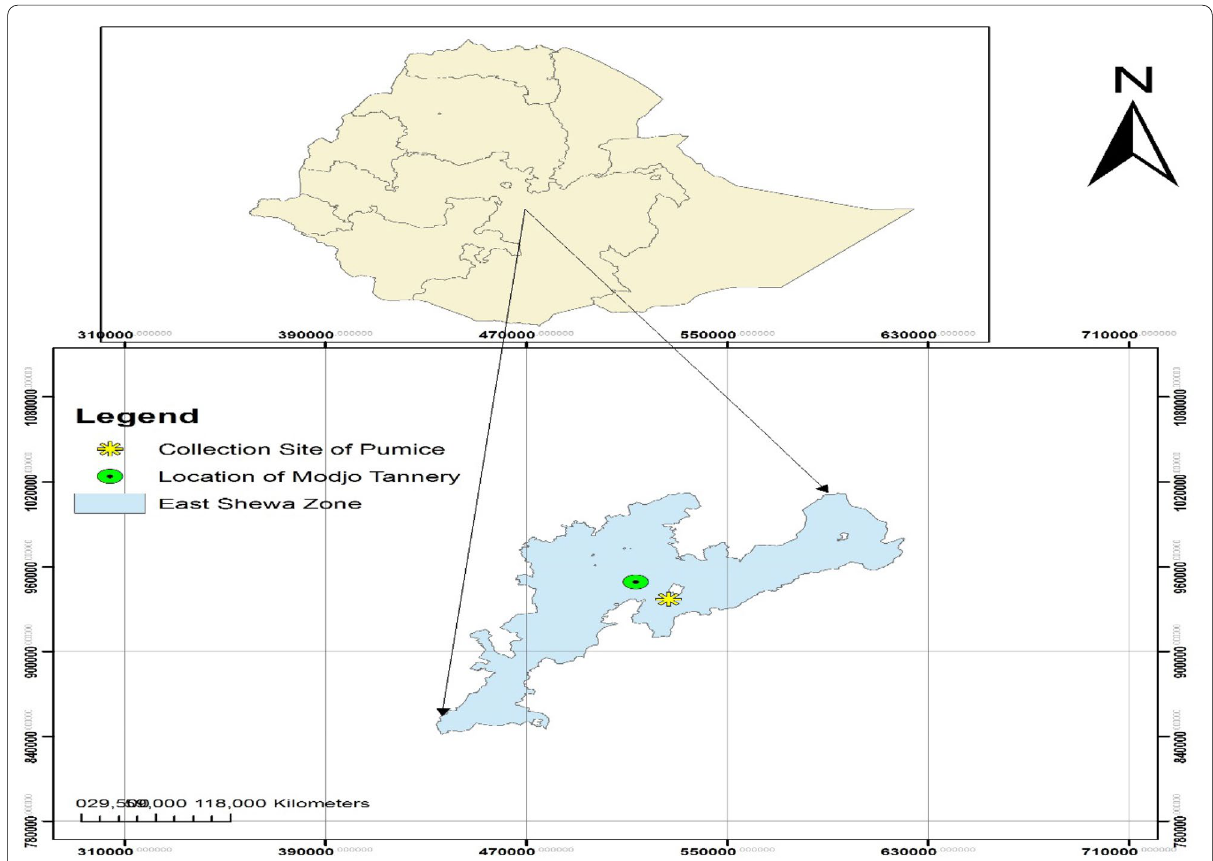
Fig. 1 Map of study area and location of